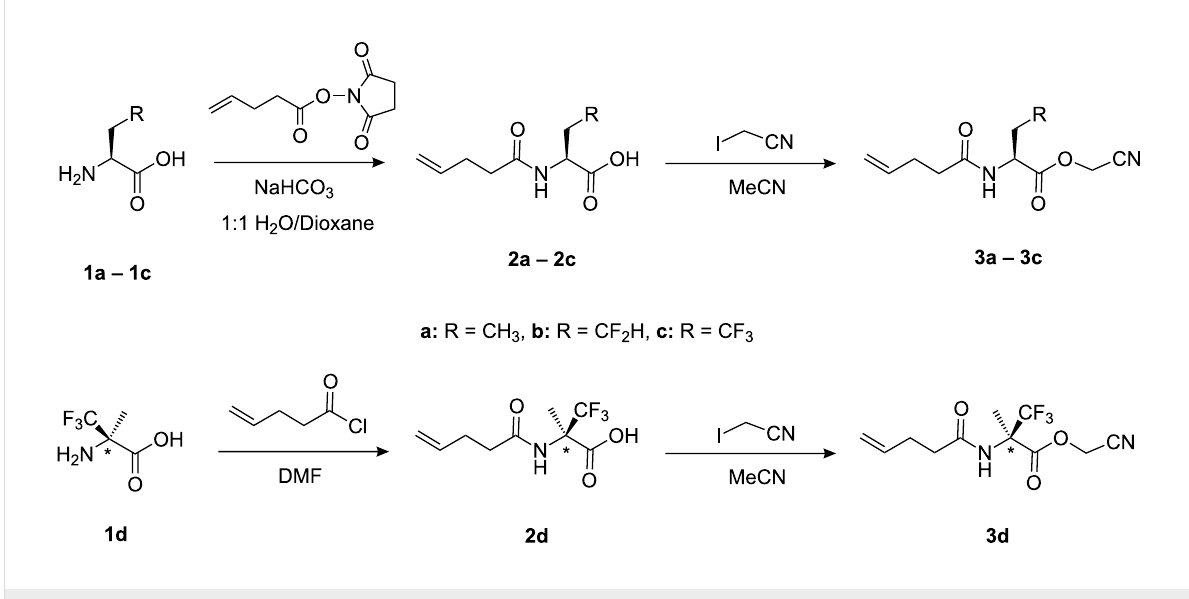
Yield of protection and activation (%)